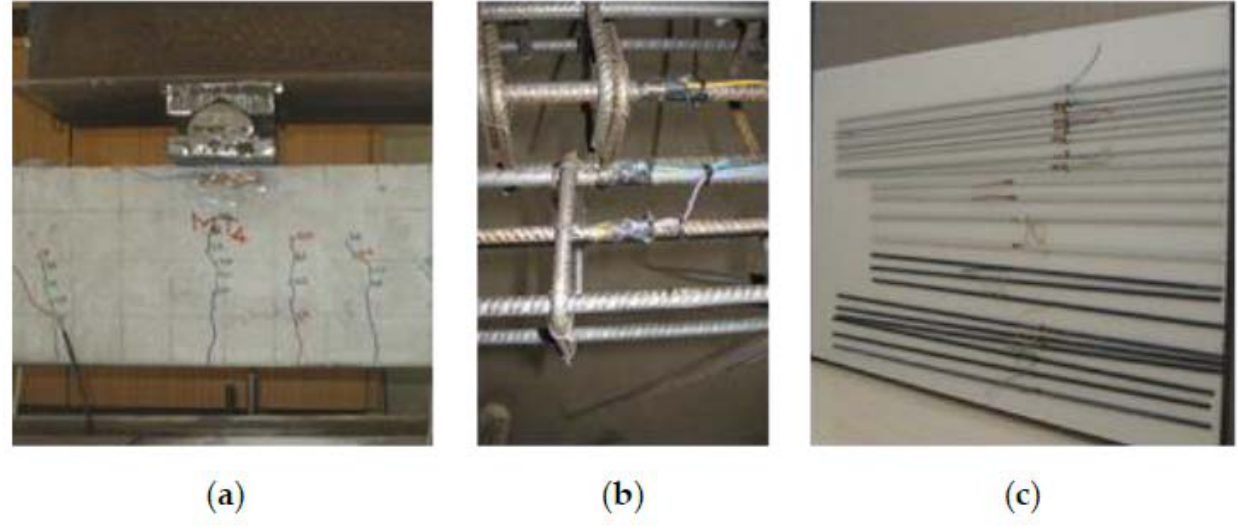
Figure 8. Strain gauges on: ( a ) Concrete; ( b ) Steel; ( c ) FRP reinforcement. Table 7. Position of strain gauge tapes (SG) and linear variable displacement transducers (LVDT) dilatometers in Sections I, II and III of the tested beams.